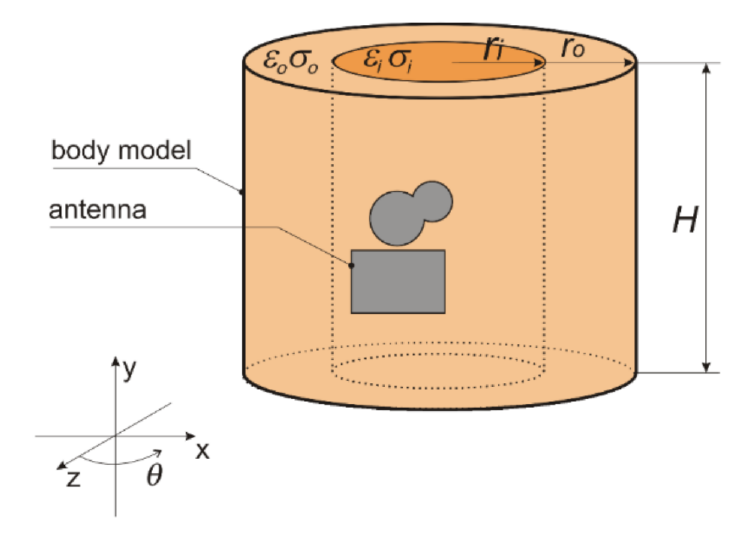
Figure 9. Simplified human body model used for antenna